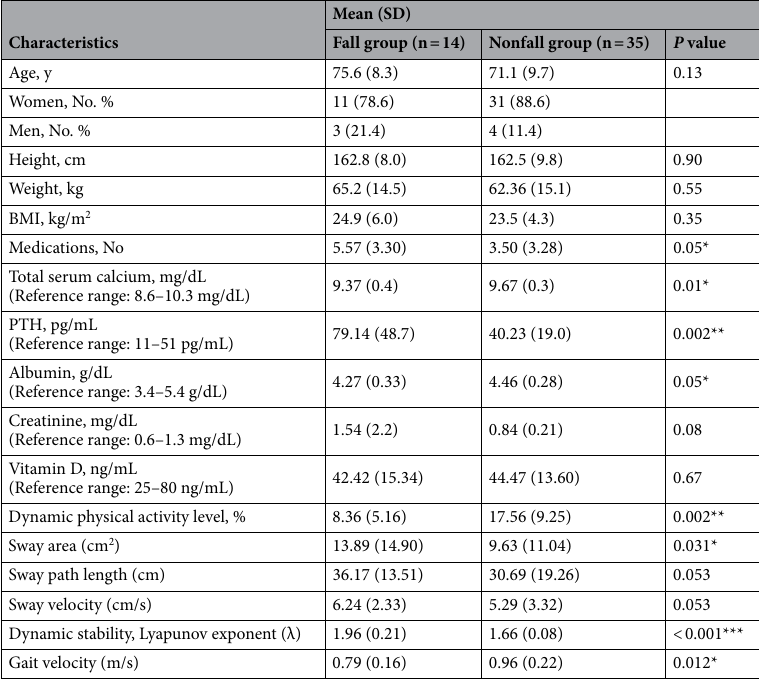
Table 1. Characteristics of participants in the fall and nonfall groups (* p < 0.05, ** p < 0.01, *** p < 0.001). BMI body mass index, PTH parathyroid